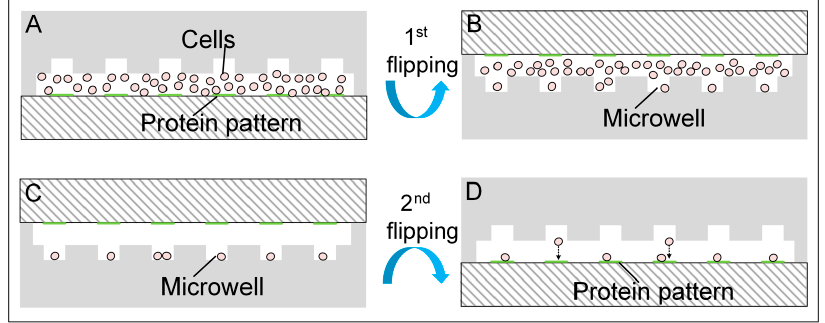
Figure 3. Cell loading processes. Schematics were not drawn to scale. ( A ) Cell suspension was loaded into the microchannel with the chip facing up; ( B ) cells settled in the microwells after the first flipping of the chip; ( C ) cells settled in the microwells after a fast flow of 20 µ L/min; ( D ) cells dropped on the protein patterns after the second flipping of the chip.